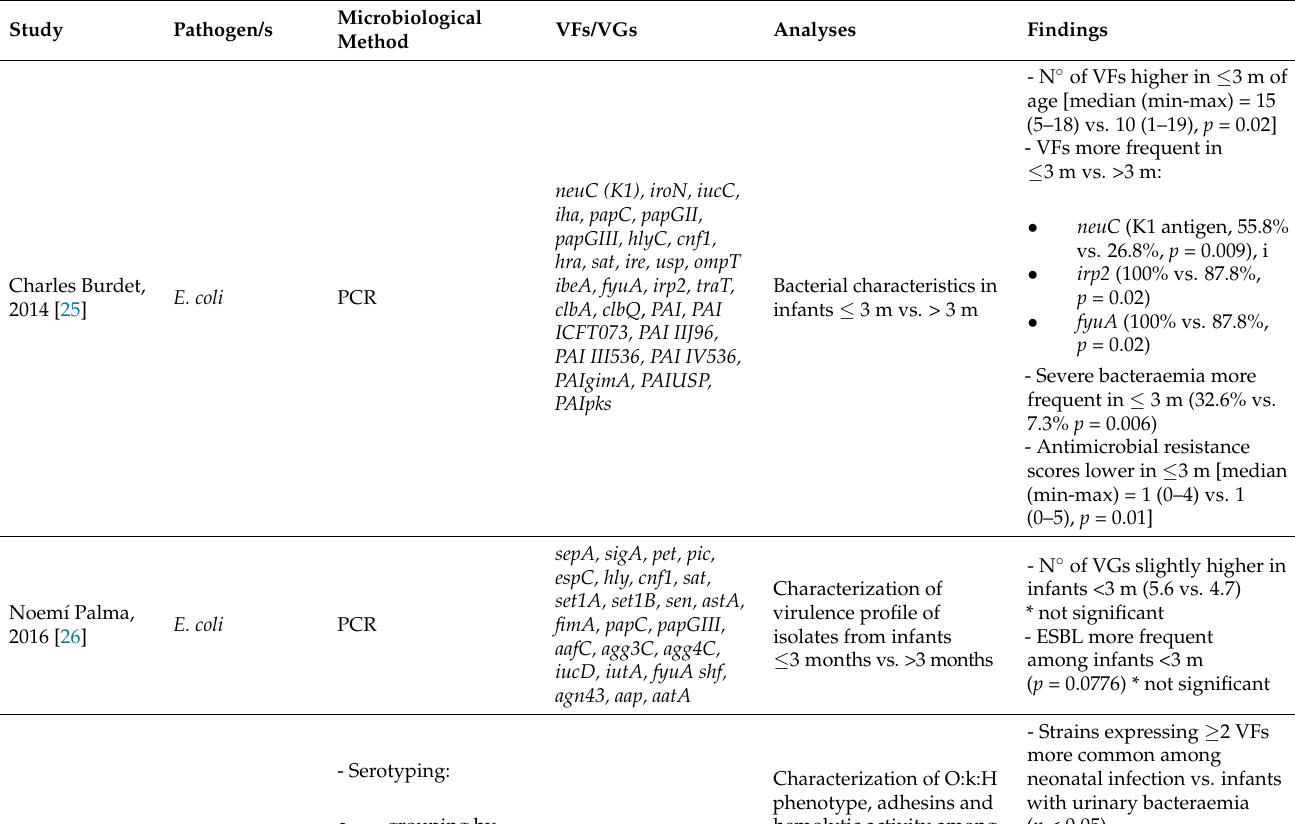
Table 3. VF profile in neonatal sepsis vs. older children and adult